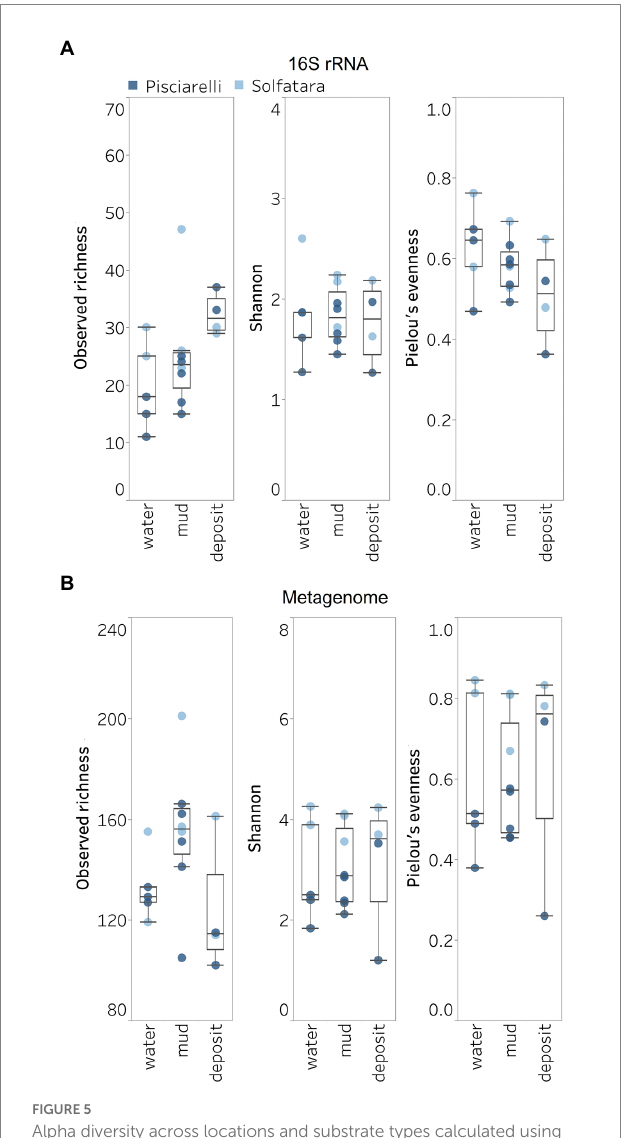
FIGURE 5 Alpha diversity across locations and substrate types calculated using species abundance from (A) metagenome-derived 16S rRNA gene and (B) metagenomic profiling.